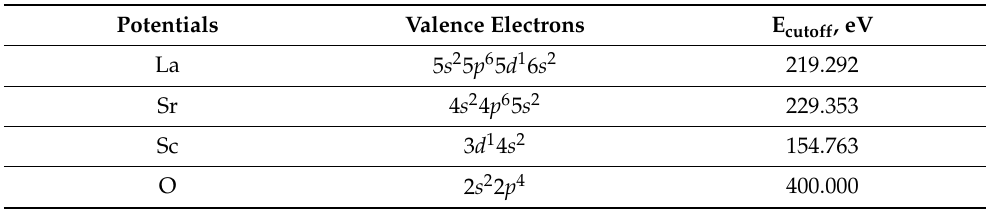
Table 1. PAW core potentials.